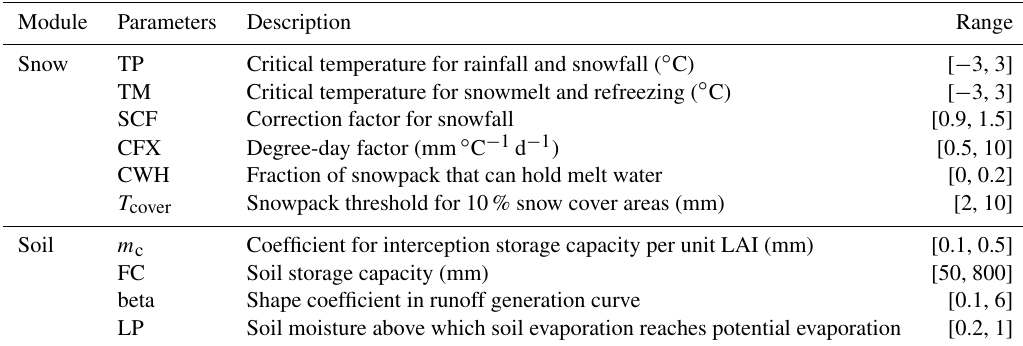
Table 3. Parameters of the HBV model and their ranges for model calibration.